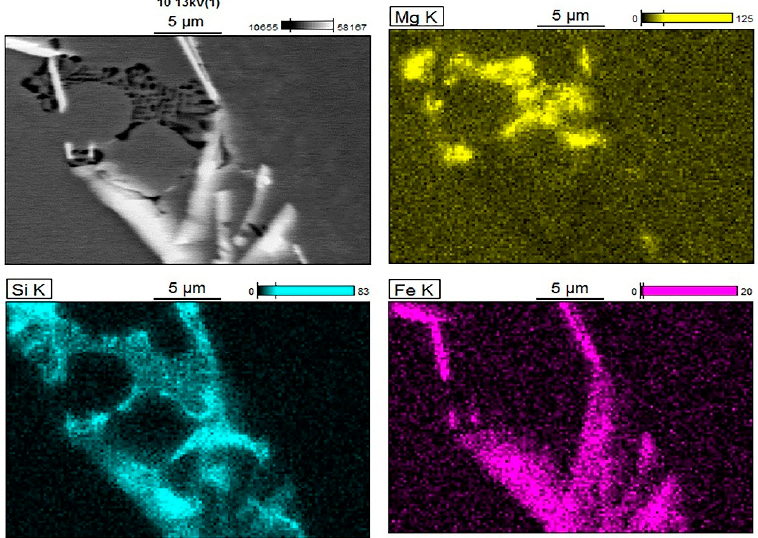
Figure 4. EDS analysis of the AlMg0.72Si0.71 wire rods after homogenization.